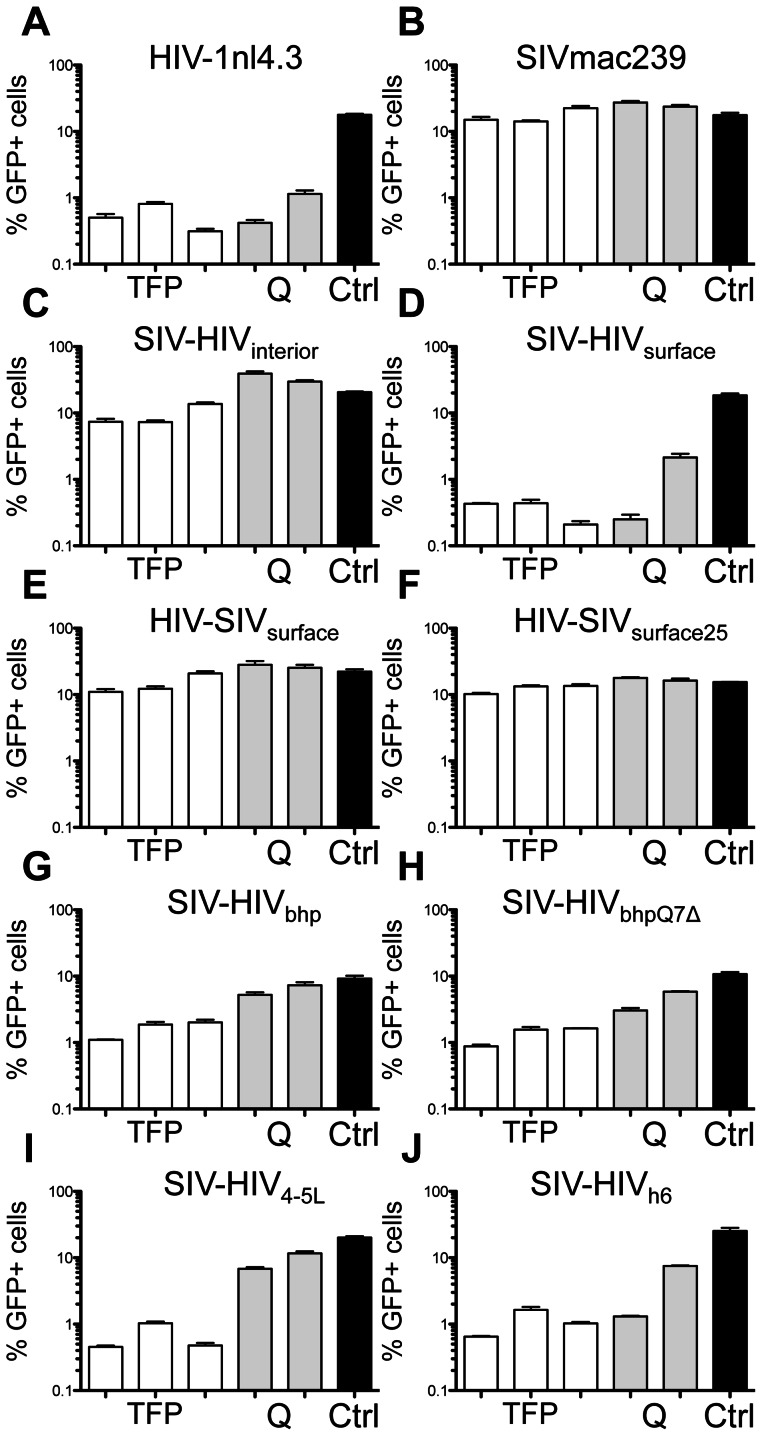
Rhesus Trim5αs recognize the capsid surface.The indicated GFP reporter viruses were used to infect CRFK cells expressing rhesus Trim5αTFP alleles mamu1, mamu2 and mamu3 (TFP) and the Trim5αQ alleles mamu4 and mamu5 (Q). Infectivity on empty vector control cells is shown (Ctrl). (A) HIV-1nl4.3. (B) SIVmac239. (C) SIV-HIVinterior. (D) SIV-HIVsurface. (E) HIV-SIVsurface. (F) HIV-SIVsurface25. (G) SIV-HIVbhp. (H) SIV-HIVbhpQΔ7.(I) SIV-HIV4–5L. (J) SIV-HIVh6. Infections were done in triplicate. Error bars indicate SEM. These results are representative of at least 3 independent experiments.